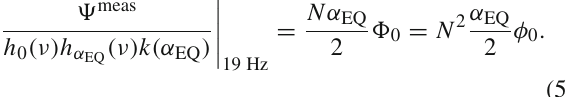
Fig. 8 Measured Cotton-Mouton peaks at 2 ν α (top) and 2 ν β (bottom) asafunctionof N .Theexperimentalpointsconnectedwithdashedlines are not corrected for the cavity response. The dots lying on the linear fit are the experimental values corrected for the cavity response. The two slopes are compatible within their errors